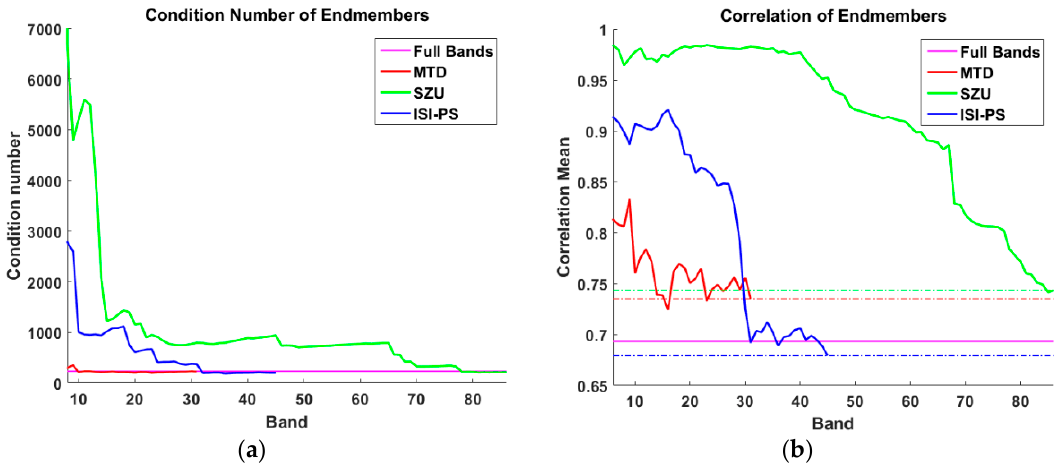
Figure 17. Plot of: ( a ) The condition number of the endmembers matrix; ( b ) The average correlation of the endmembers’ correlation matrix for the different band selection methods by increasing the number of the selected bands.